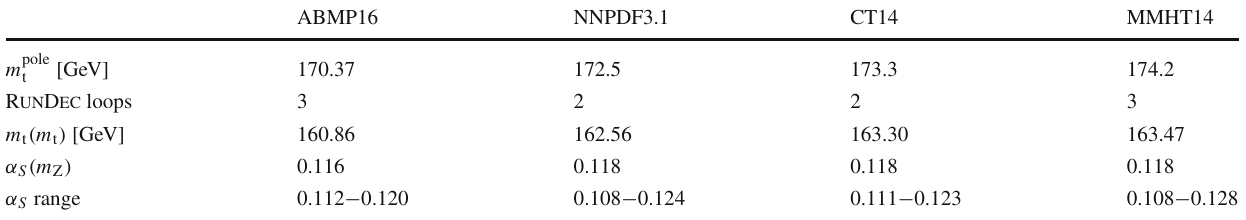
betweenthepost-fitandthepre-fitvaluesofthenuisanceparameternor- malized to its pre-fit uncertainty. The horizontal lines at ± 1 represent the pre-fit uncertainty